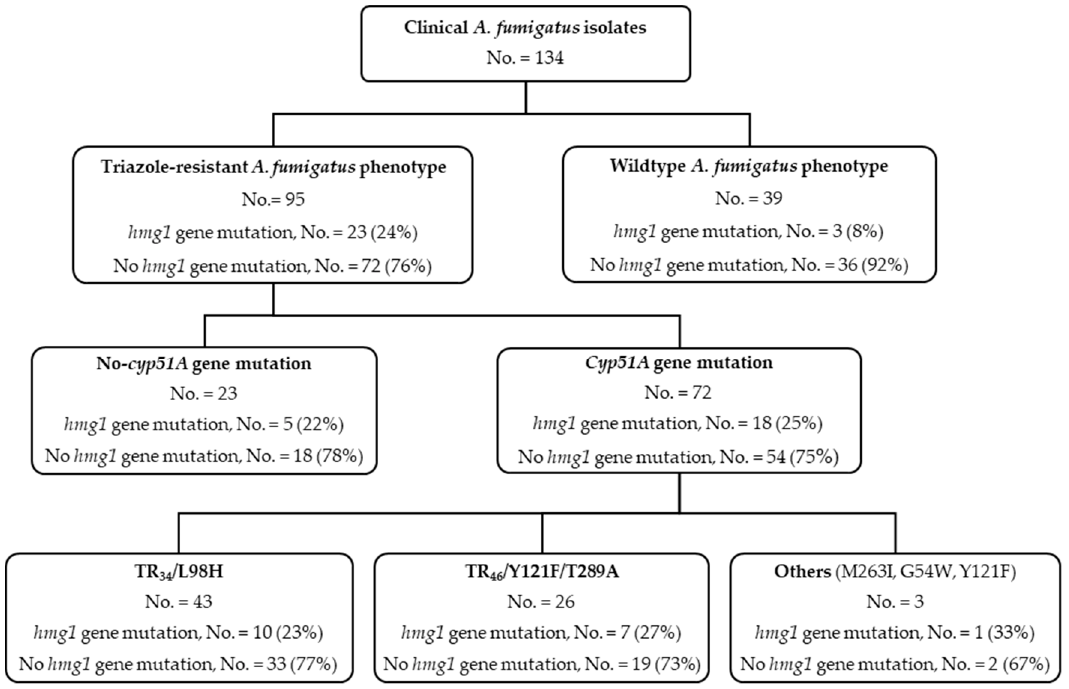
Figure 1. hmg1 gene mutations in triazole-susceptible and triazole-resistant Aspergillus fumigatus clinical isolates.